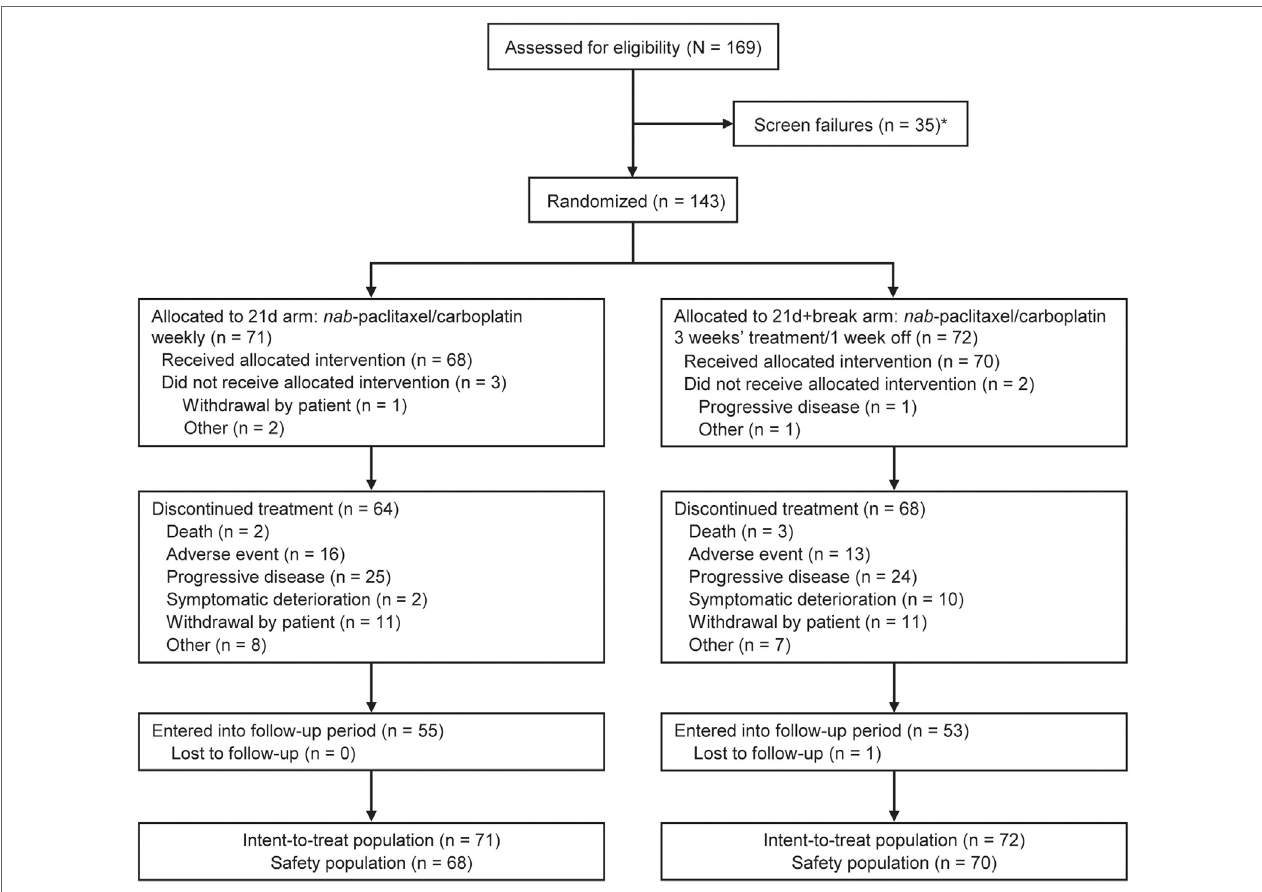
FigUre 1 | CONSORT diagram for ABOUND.70 + . *A patient could have been screened more than once but was only counted once in total